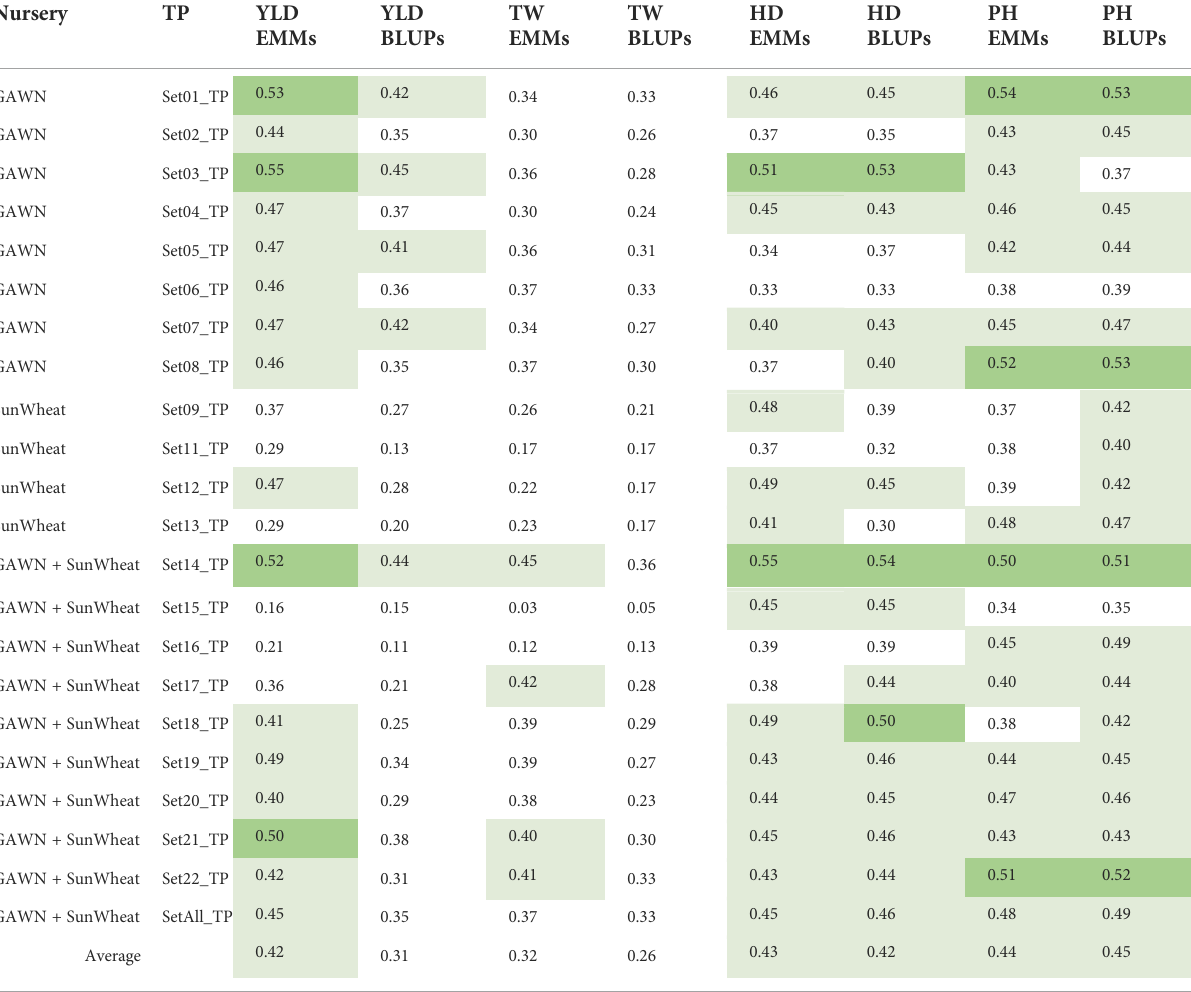
TABLE 1Five-fold CVusing estimated values (EMMsand BLUPs)of22 TPs (SupplementaryTable S2)andthe predictionaccuracy to predictGEBVs for YLD, TW, HD and PH. Nursery TP YLD